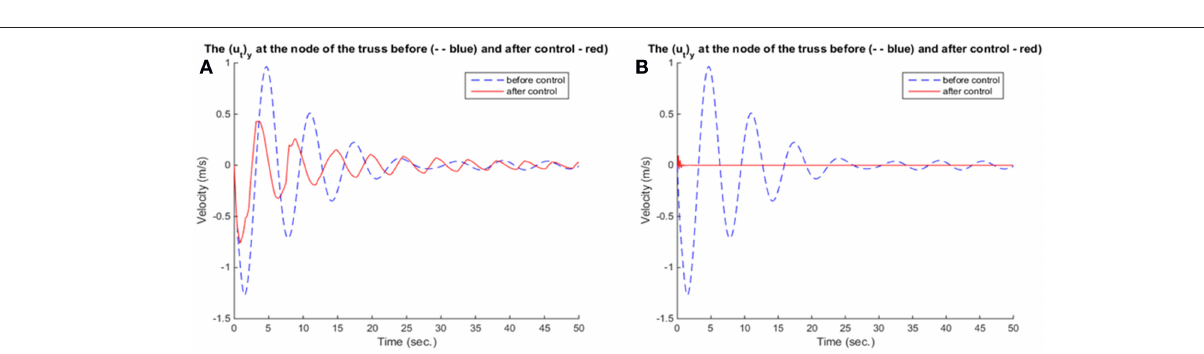
FIGURE 9 | Velocity of node 16 for (A) fuzzy controller and (B) neuro-fuzzy controller.